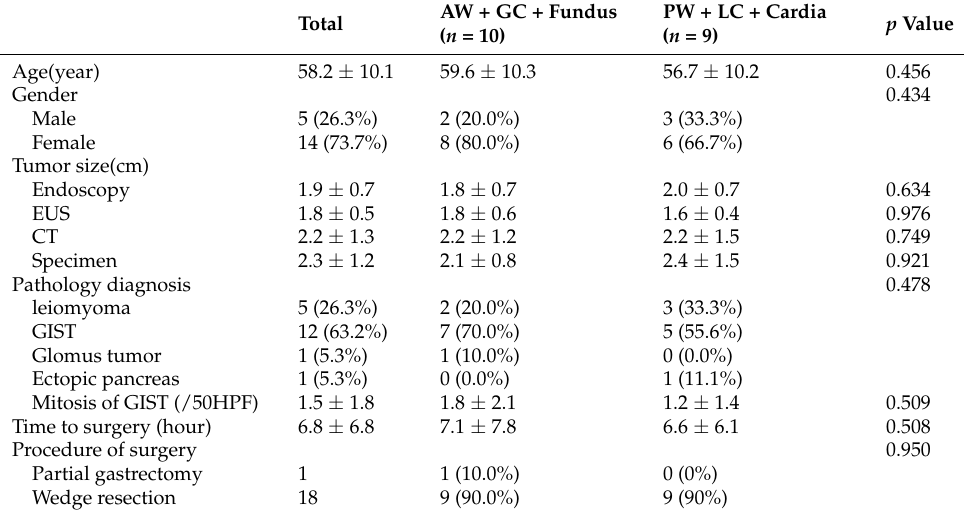
Table 2. Patient characteristics.